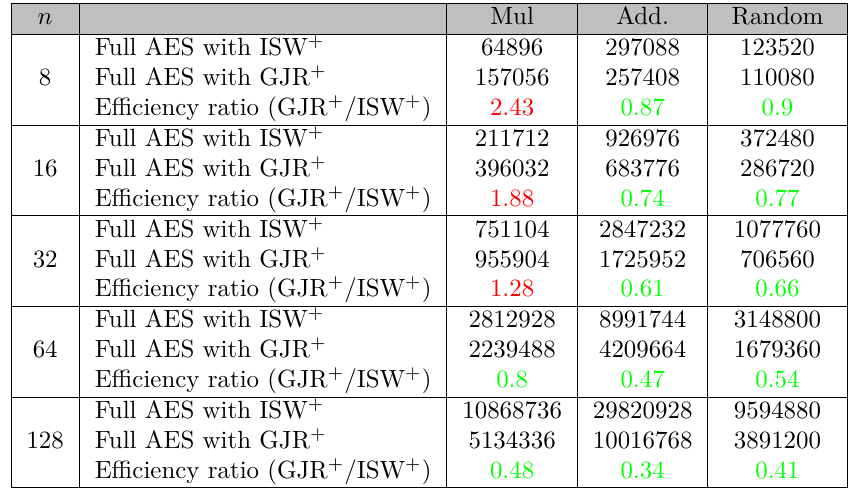
Table 7: Performances comparison for masked